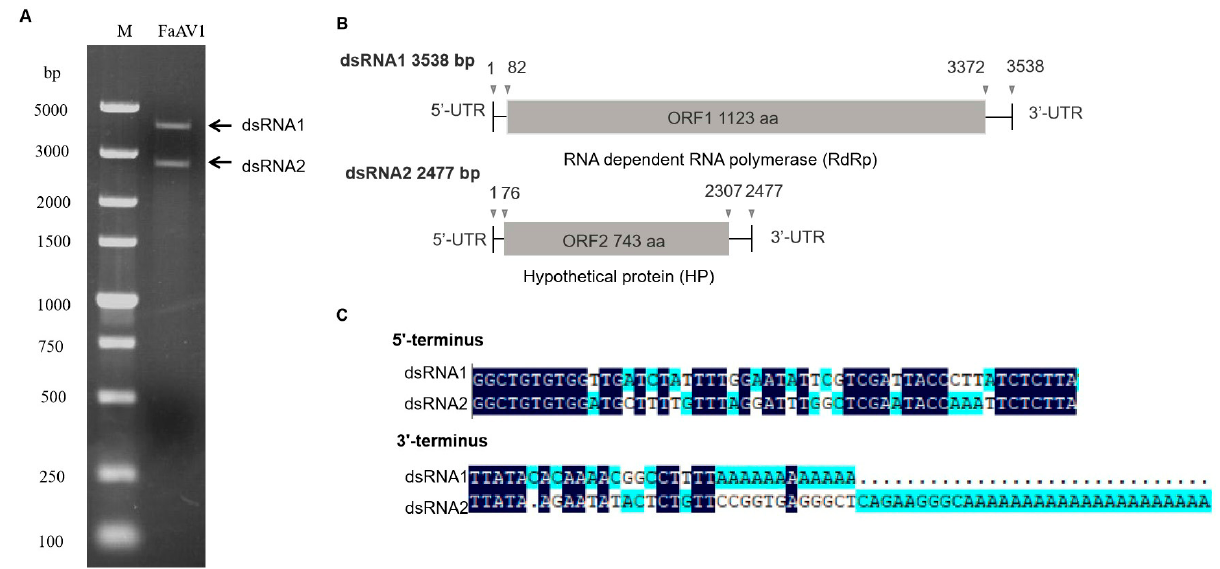
Figure 1. Double-stranded RNAs (dsRNAs) extracted from Fusarium avenaceum strain GS-WW-224. ( A ) 1.0% ( w/v ) agarose gel electrophoretic profiles of dsRNA extracted from F. avenaceum strain GS-WW-224, which was treated with DNase I and S1 nuclease. Lane M: DNA molecular marker DL 5000. ( B ) Schematic representation of the complete genome of Fusarium avenaceum alternavirus 1